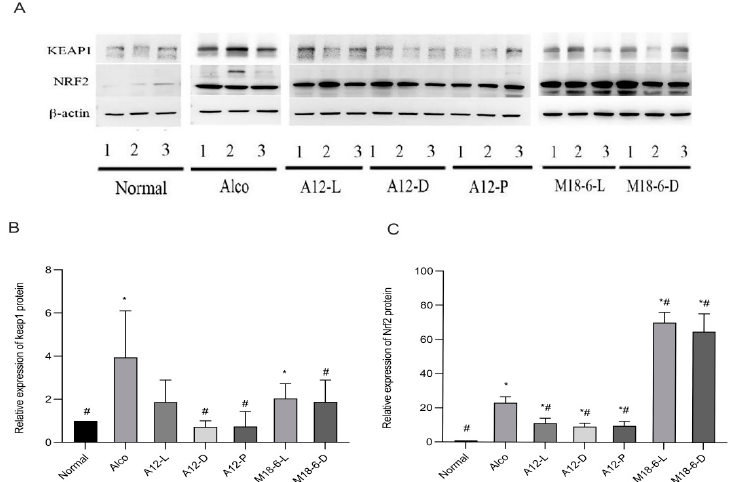
Figure 8. Expression of keap1/Nrf2 proteins in different treated groups. ( A ) Western blotting map. ( B ) Liver keap1 mRNA expression level; ( C ) Liver Nrf2 mRNA expression level. Compared with normal group ( p < 0.05) #, compared with Alco group ( p < 0.05) *. Keap1: Kelch-1ike ECH-associated protein l; Nrf2: Nuclear factor erythroid2-related factor 2. Normal: normal saline-fed; Alco: